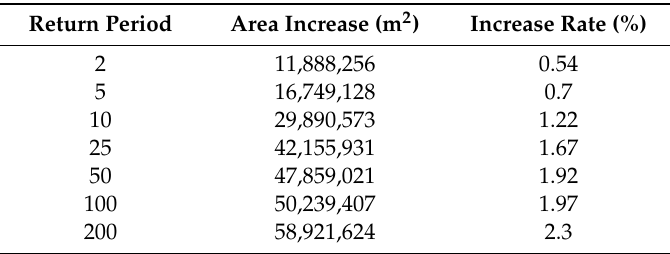
Table 3. Comparison of the increase rate of soil erosion area increase under the baseline and A1B-S scenarios for various return